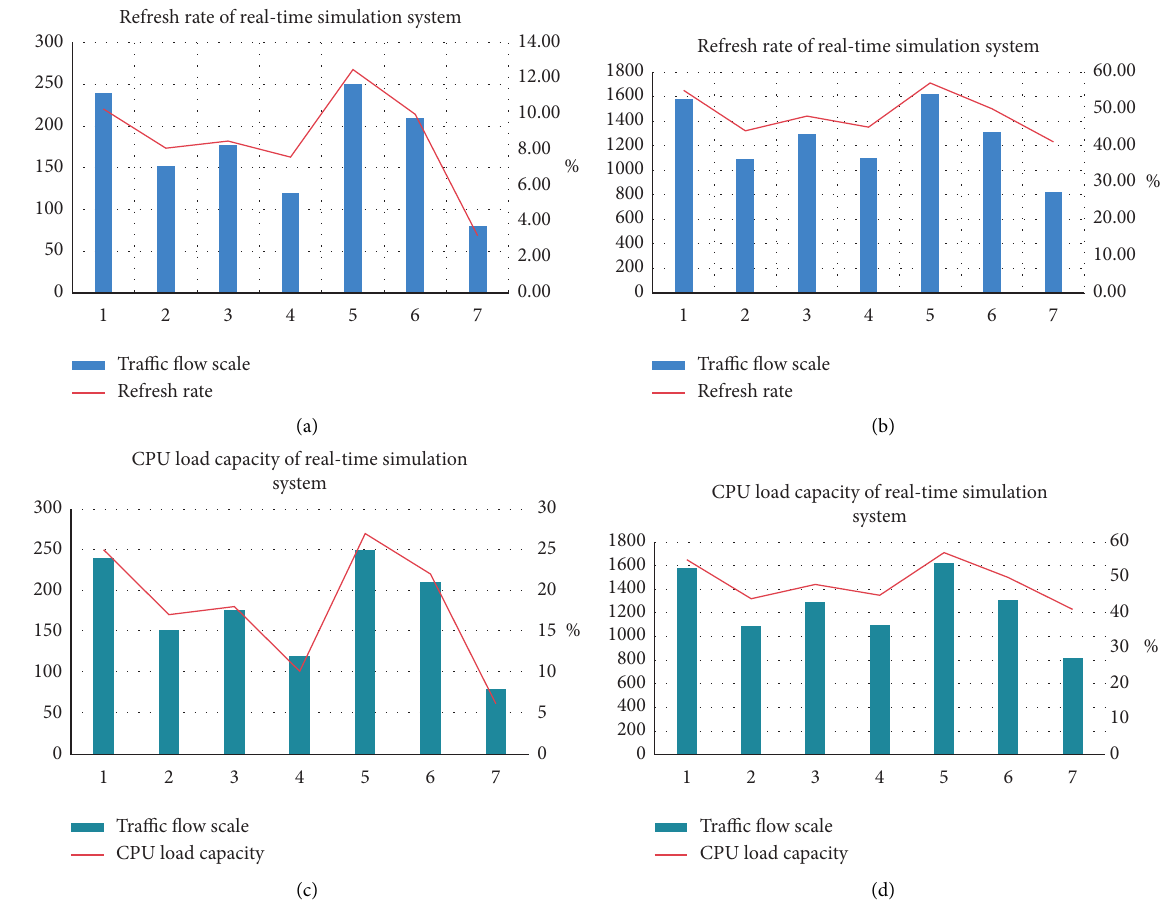
Figure 13: Simulation platform performance test results.